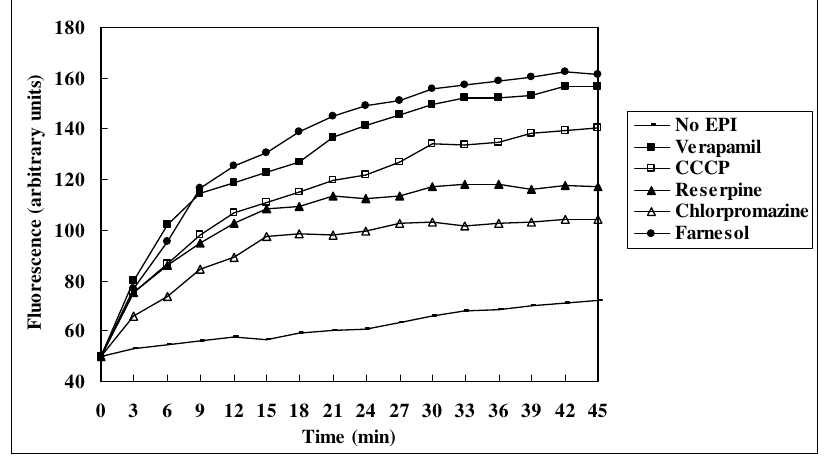
Figure 2. Effect of EPIs on the accumulation of EtBr in M. smegmatis mc 2 155 cells. Concentrations of reserpine, chlorpromazine, verapamil, CCCP and farnesol are at half their MICs (See also Table